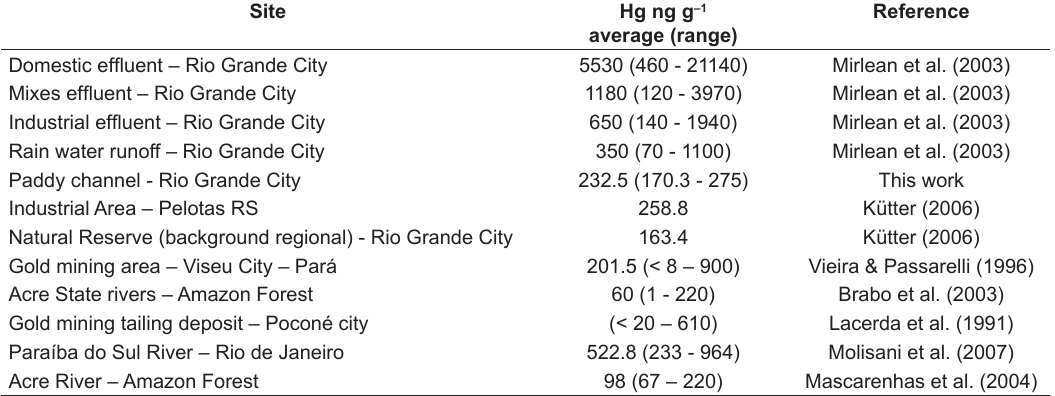
Table 2. Comparison among different sources of Hg in SPM for different sites in